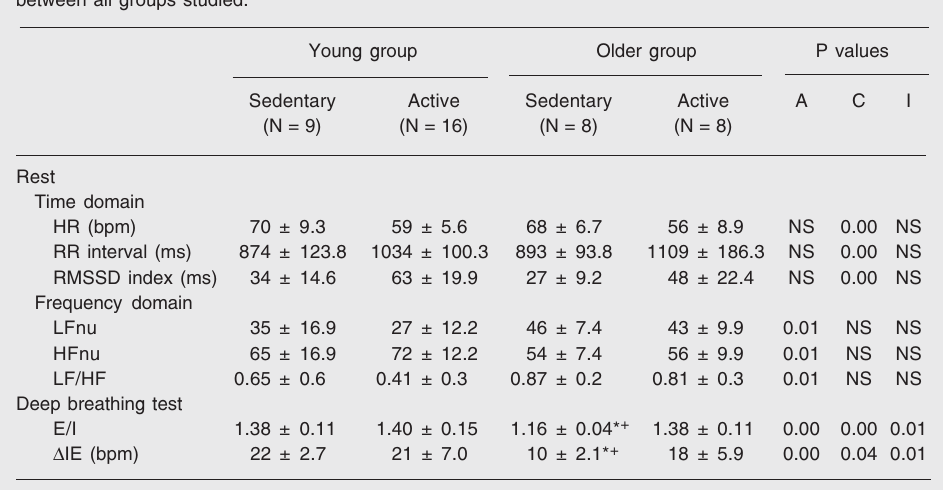
Table 2. Comparison of the heart rate variability indices in time and frequency domain analysis during the resting supine condition, and respiratory sinus arrhythmia indices calculated by the deep breathing test, between all groups